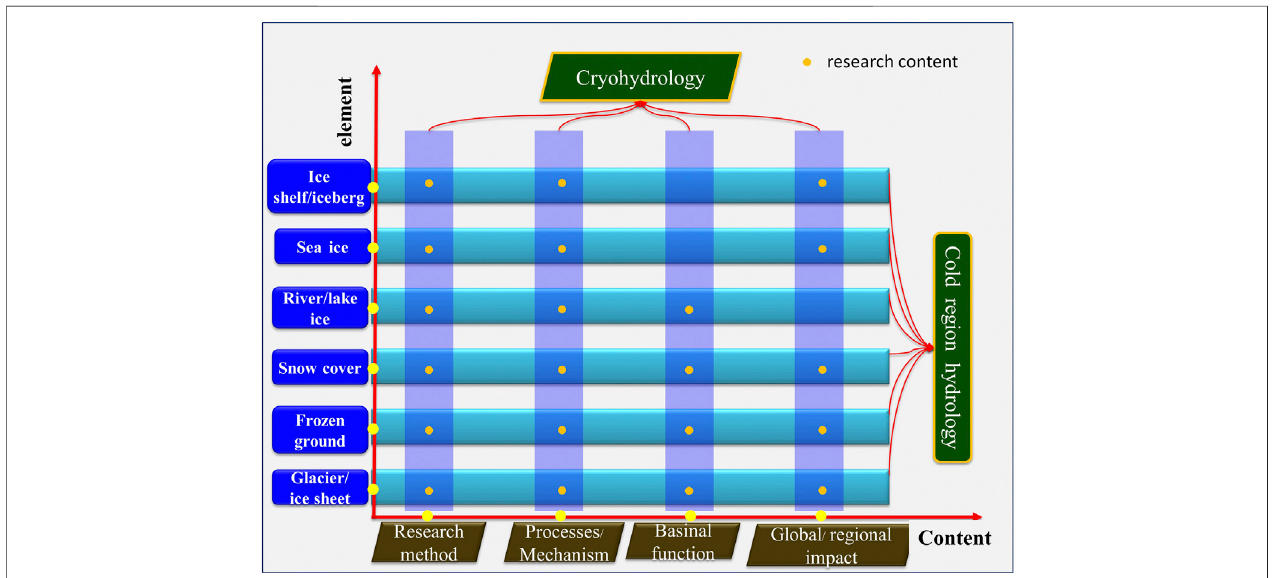
FIGURE 2 | Scope of cryohydrology and cold region hydrology. Note that cryohydrology focuses on the common hydrological law of different elements of the cryosphere, while cold region hydrology focuses on the content of the research method, processes/mechanism, basinal function, and global/regional impact of the single element of the